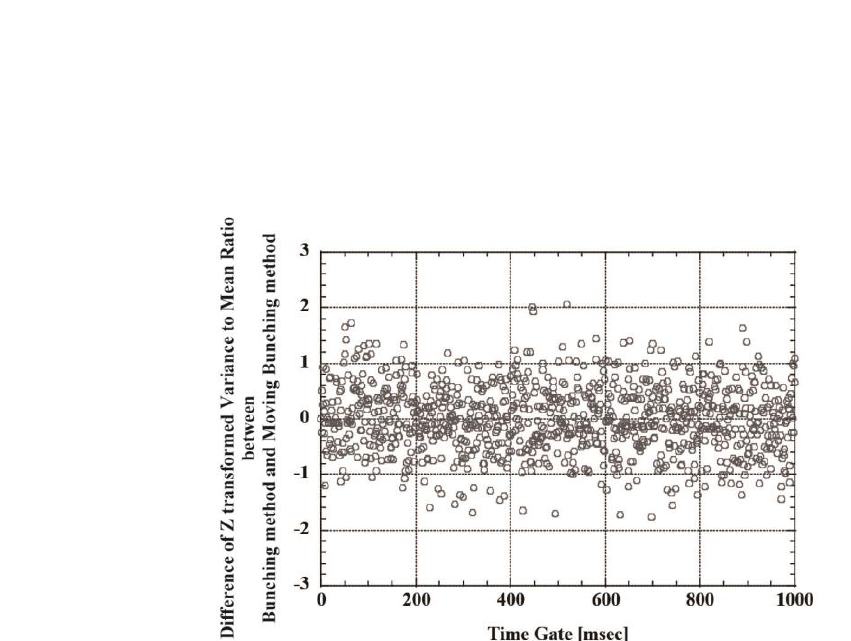
Figure 6. An example of difference between the Z transformed results of bunching method and moving bunching method